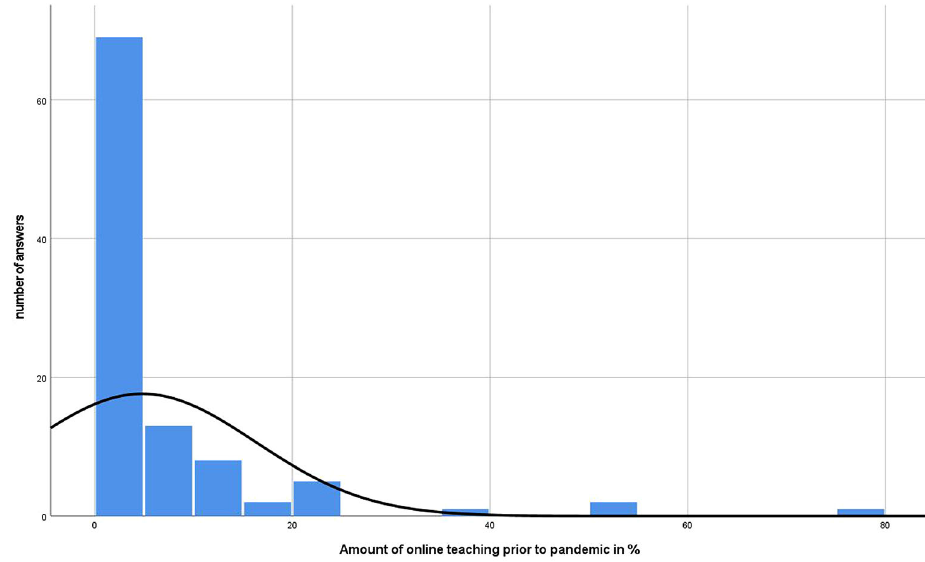
Figure 4. Results of online teaching of participants prior to pandemic in